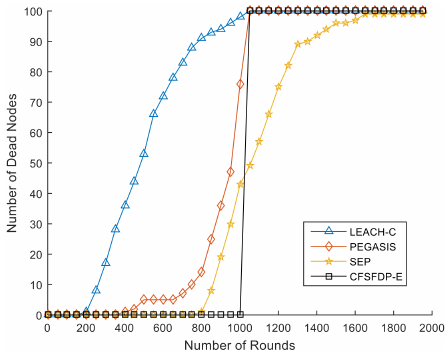
Figure 6. Network lifetime comparison of LEACH-C, PEGASIS, SEP and